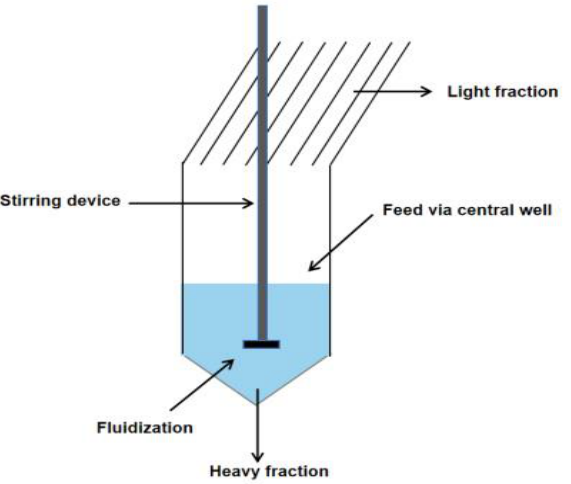
Figure 1. Schematic representation of the TARC (trapezoidal inclined channel agitated reflux classifier).